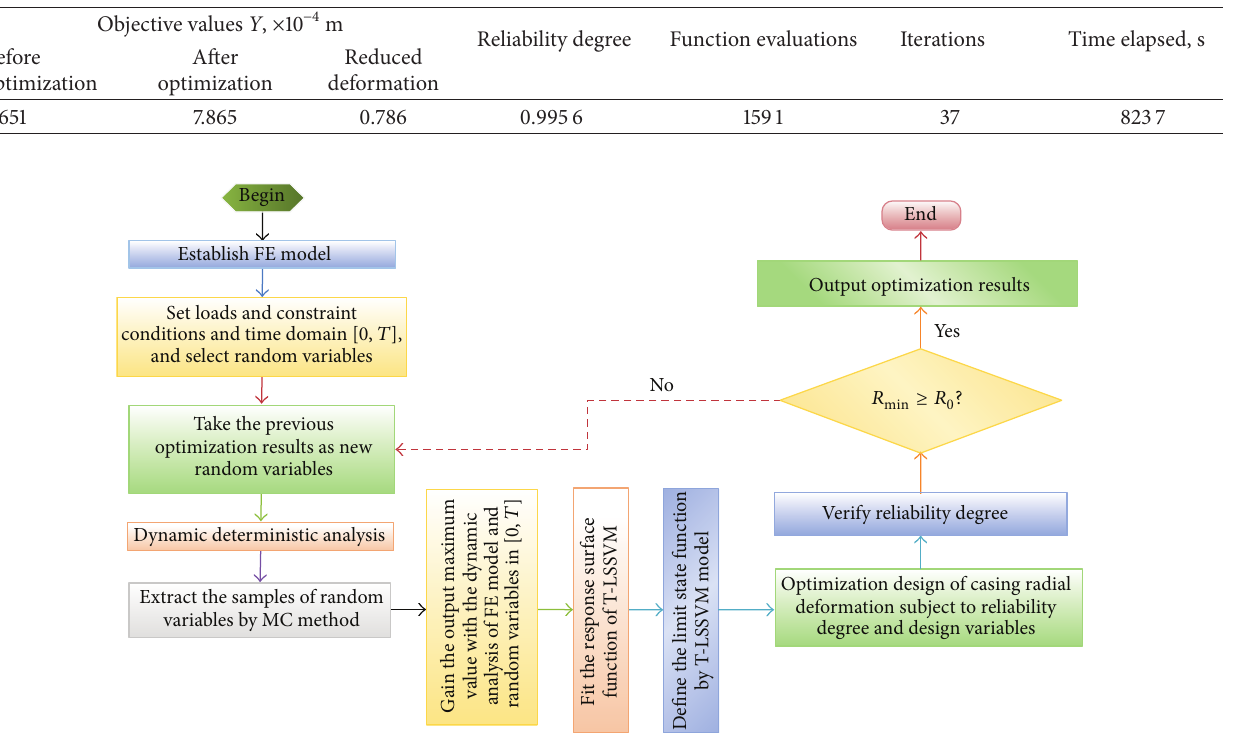
Figure 3: Procedure of dynamic reliability optimal design analysis with T-LSSVM.